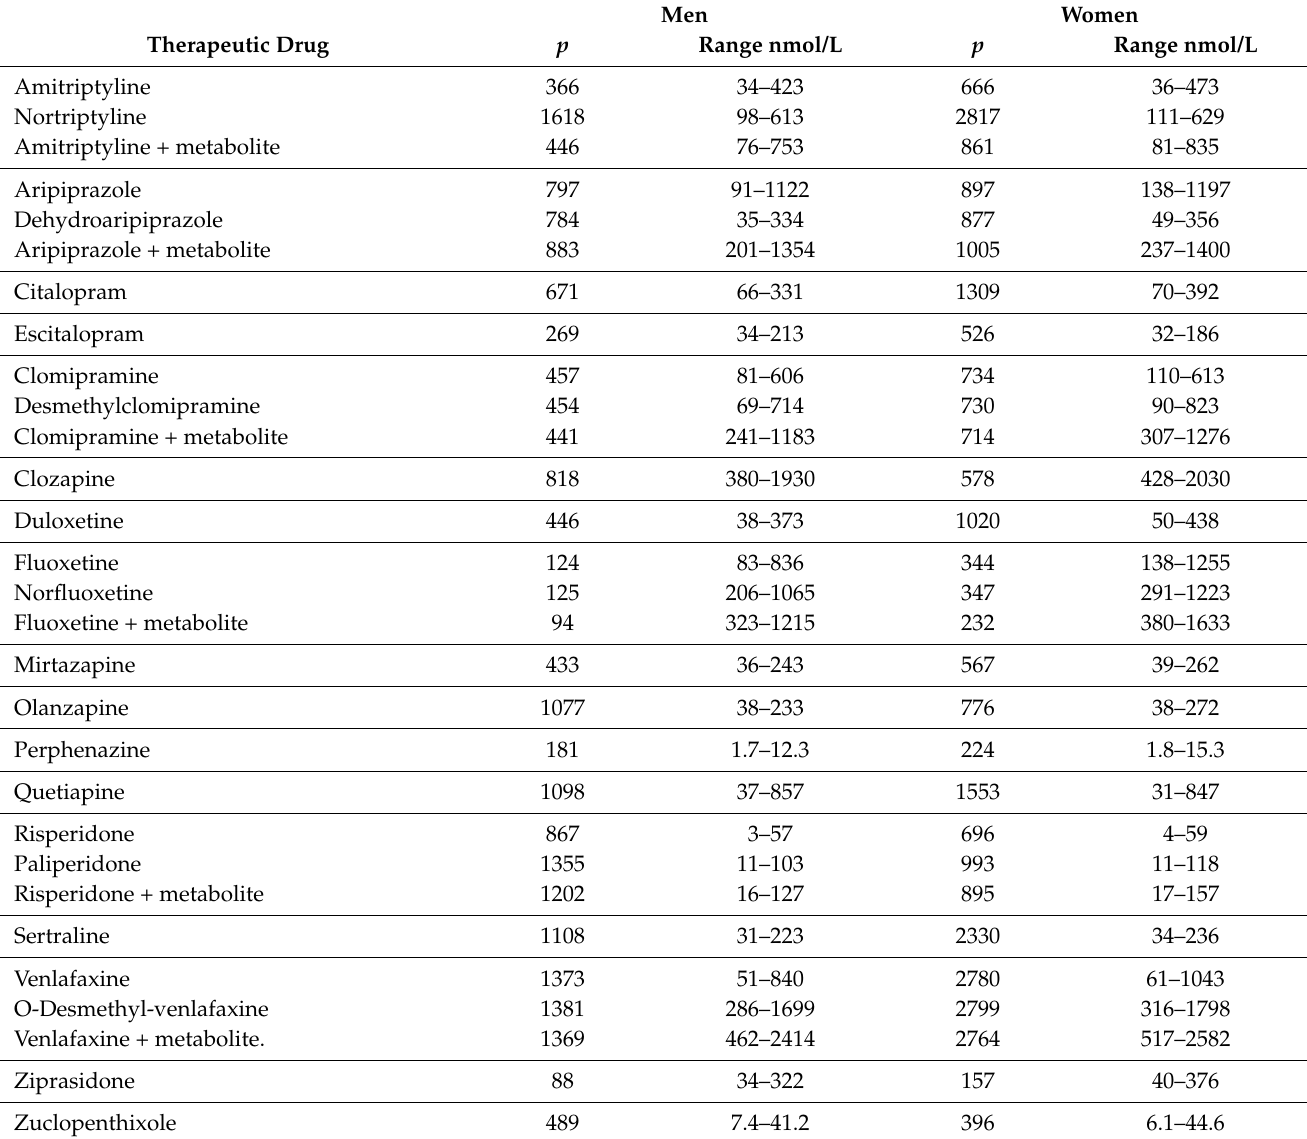
Table 4. Comparison between calculated 10–90 percentile therapeutic analytical ranges for men and women performed on the data set from Aarhus University Hospital. Here, p indicates the number of patients that the calculations are based on. For additional statistics, see Table